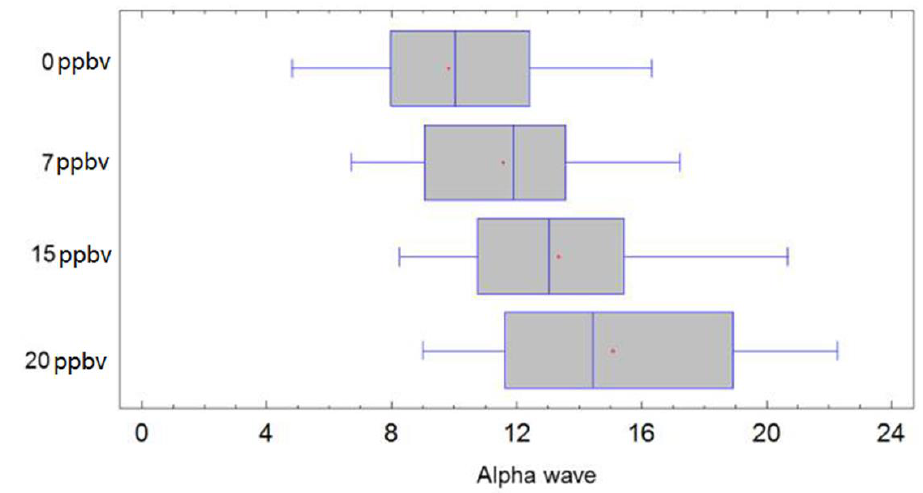
Figure 2. The alpha wave values of 30 participants (15 male and 15 female) at different monoterpene concentrations, as obtained from Exp 2.